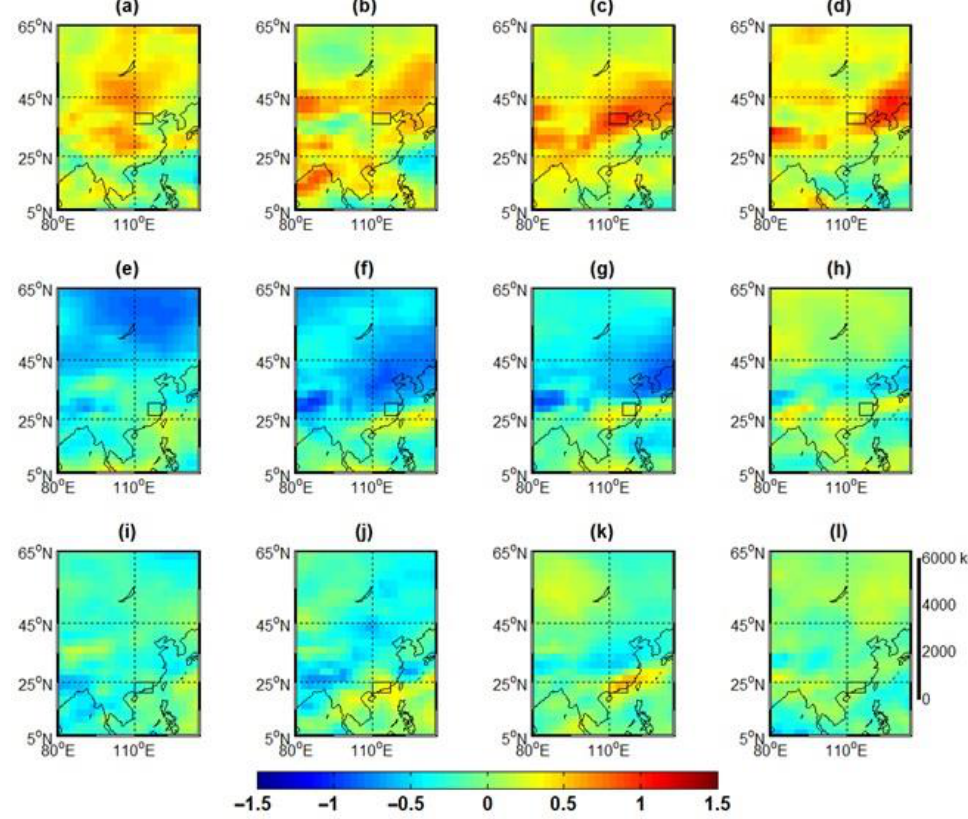
Figure 8. As in Figure 6, but for potential pseudo-equivalent temperature ( θ se ). ( a – d ) North China (NC), ( e – h ) Yangtze River Valley (YRV), and ( i – l ) South China (SC).